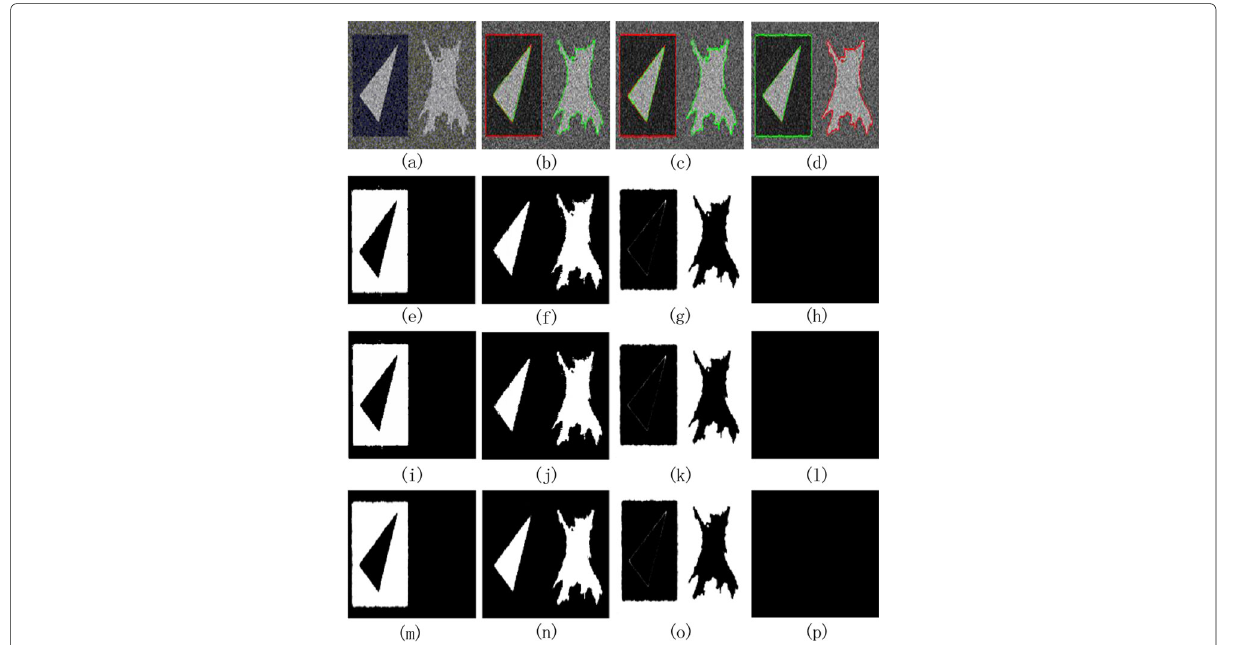
Fig. 5 Three-phase segmentation of original Vese-Chan method, TV regularization method, and our method. a The input synthetic image. b The segmentation of original Vese-Chan method. c The segmentation of TV regularization method. d The segmentation of our method. e – h Different regions obtained via the original Vese-Chan method. i – l Different regions obtained via TV regularization method. m – p Different regions obtained via our method